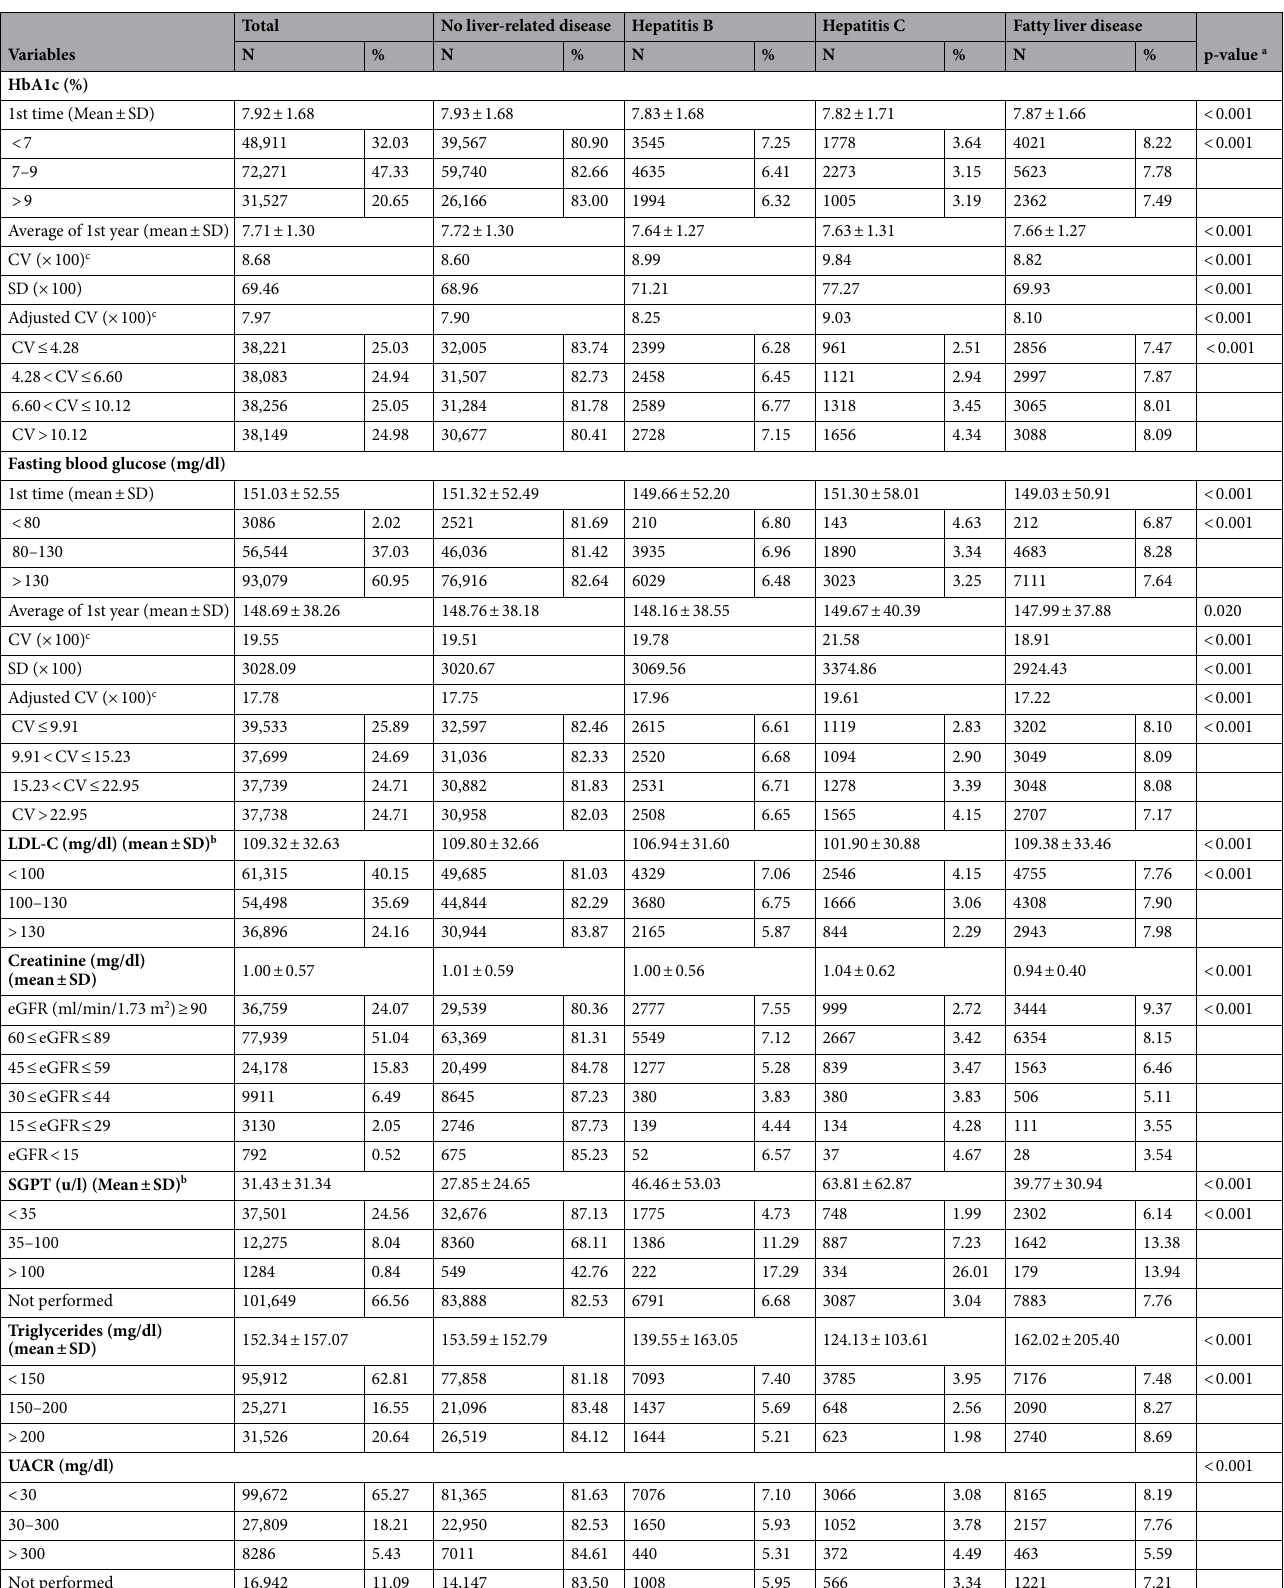
Table 1. The baseline characteristics of the incident cardiovascular disease in patients with T2DM. a χ